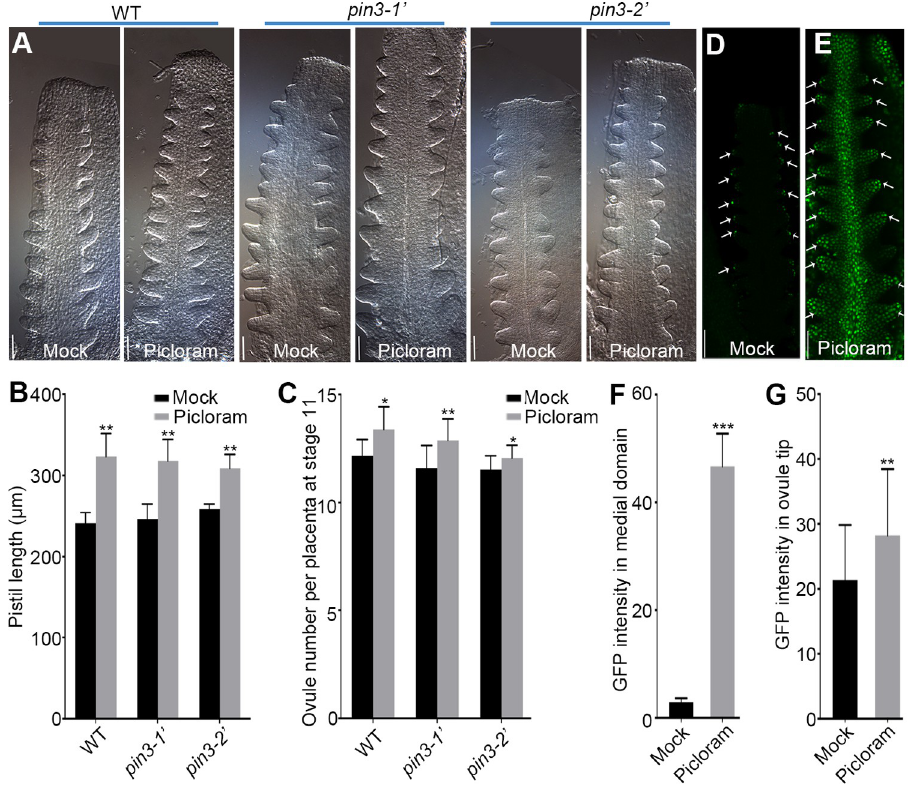
Fig 5. The picloram treatment recovers the ovule number of pin3 mutants by altering auxin signal. (A) DIC images of the ovule initiation at floral stage 9c. Flowers grew for 2 days following the mock solution or 5 μ M picloram treatment for 24 h. (B) Pistil length at floral stage 9c under picloram treatment. (C) Ovule number per placenta at floral stage 11. (D-E) Expression pattern of DR5 :: NLS-eGFP under the treatments of mock solution (D) or 5 μ M picloram (E). White arrows indicate the ovule tips with GFP fluorescence. (F-G) GFP fluorescence intensity in the medial domain of the pistil (F) and ovule tip (G). Bars: 20 μ m (A) and 50 μ m (D-E). Data are presented as the mean ± SD (n = 12). Significant differences were revealed by one-way ANOVA ( � P < 0.05, �� P < 0.01, ��� P <